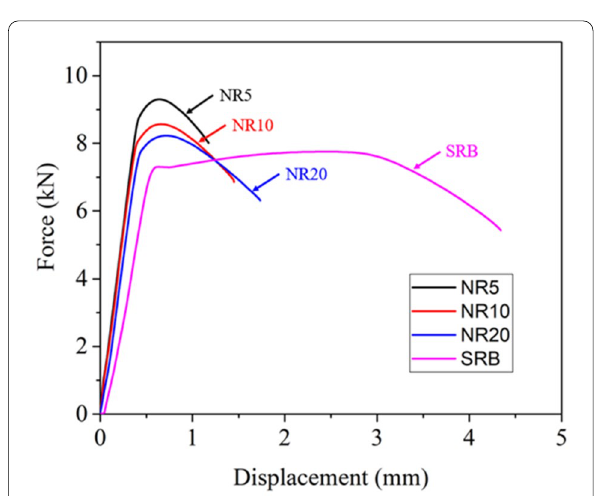
Figure 4 Force–displacement relationship of tension